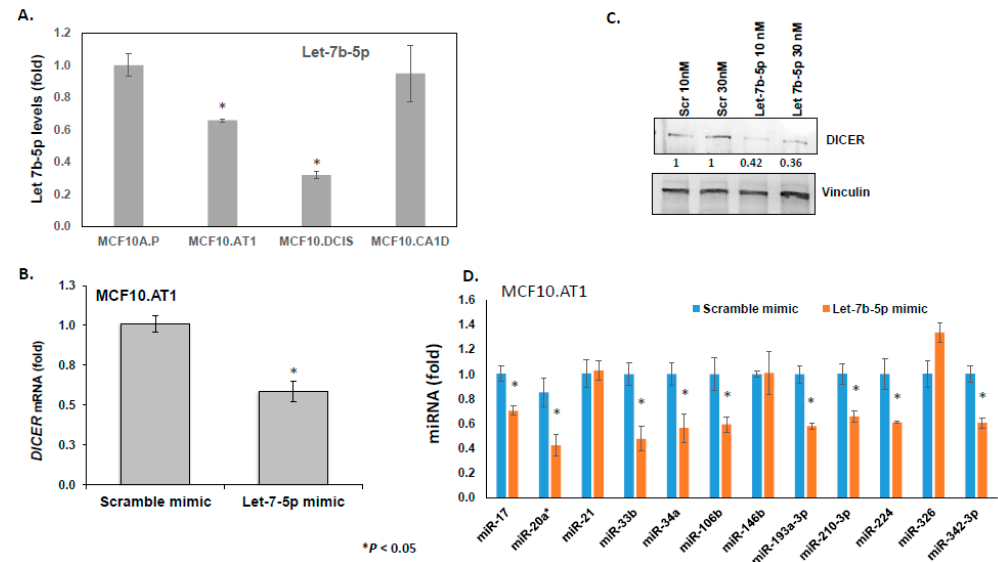
Figure 4. let-7b-mediated DICER regulation causes global miRNA changes. ( A ) Relative mean expression of endogenous let-7b-5p miRNA assayed by TaqMan-based qPCR across the breast cancer progression panel. let-7b levels were first normalized to a small nucleolar RNA, RNU44. The Ct values were converted to fold change using the delta Ct method and setting the lowest gene expression (MCF10A.P cells, in this case) as 1. ( B ) Relative mean expression of endogenous DICER1 mRNA assayed by qPCR in MCF10.AT1 cells transfected with either scramble mimic or let-7b-5p mimics. DICER1 mRNA levels were first normalized to a housekeeping gene, RPL19. The Ct values in let-7b-5p mimic-treated cells were converted to fold change using the delta Ct method and setting the gene expression in scramble-treated MCF10.AT1 cells as 1. ( C ) Western blot analysis and its quantification showing repression in endogenous DICER1 protein caused by let-7b-5p mimics compared to scramble control mimics in preneoplastic MCF10.AT1 cells. DICER protein levels were normalized to a loading control, vinculin. The graphs represent mean values + SEM. ( D ) Relative mean expression of indicated miRNAs as assayed by qPCR in MCF10.AT1 cells transfected with either scramble mimic or let-7b-5p mimics. miRNA levels were first normalized to a loading control, RNU44. The Ct values in let-7b-5p mimic-treated cells were converted to fold change using the delta Ct method and setting the gene expression in scramble-treated MCF10.AT1 cells as 1. The graphs represent mean values + SEM. p values were calculated using student’s t test. * indicates p < 0.05.